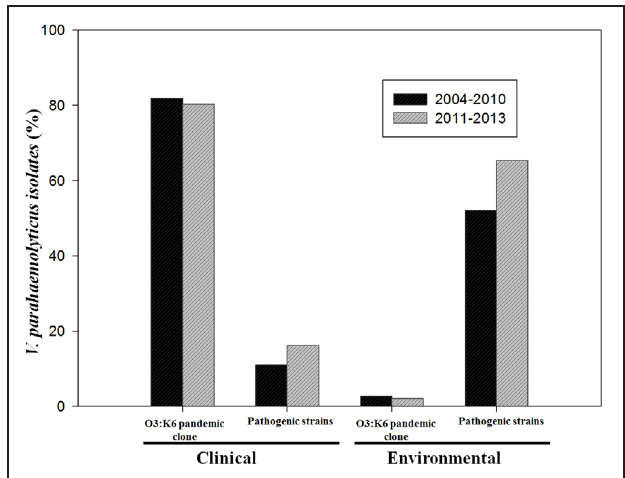
FIGURE 2 | Prevalence of pandemic Vibrio parahaemolyticus O3:K6 and pathogenic strains isolated from environmental and clinical samples that were collected in periods 2004–2010 or